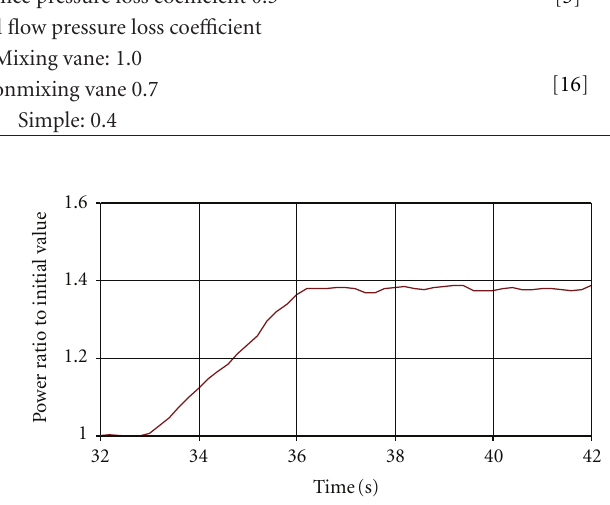
Figure 9: Transient power during the PI test.